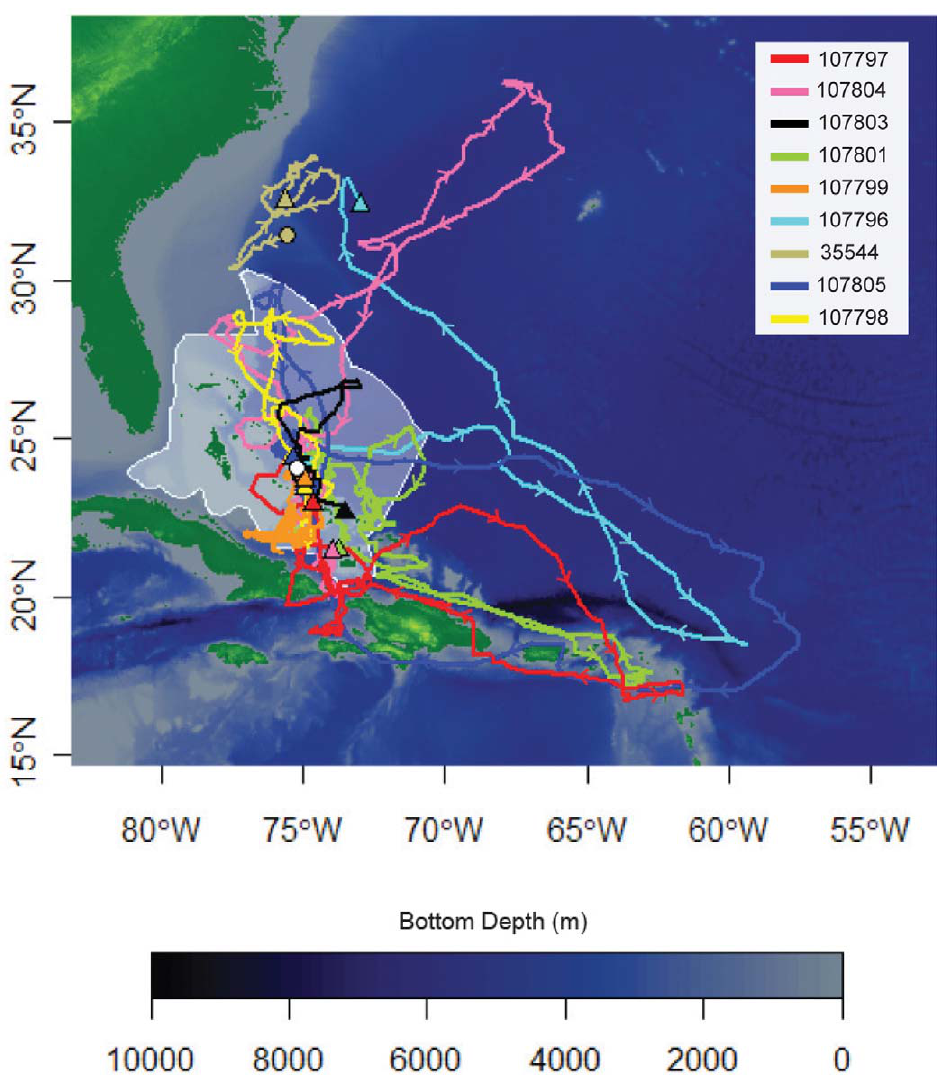
Figure 2. Map with bottom depth (m) showing filtered tracks for nine oceanic whitetip sharks equipped with Standard Rate tags. Colored lines represent tracks from individuals (listed by tag ID); triangle indicate pop-up location. Arrows on colored lines show direction of movement.